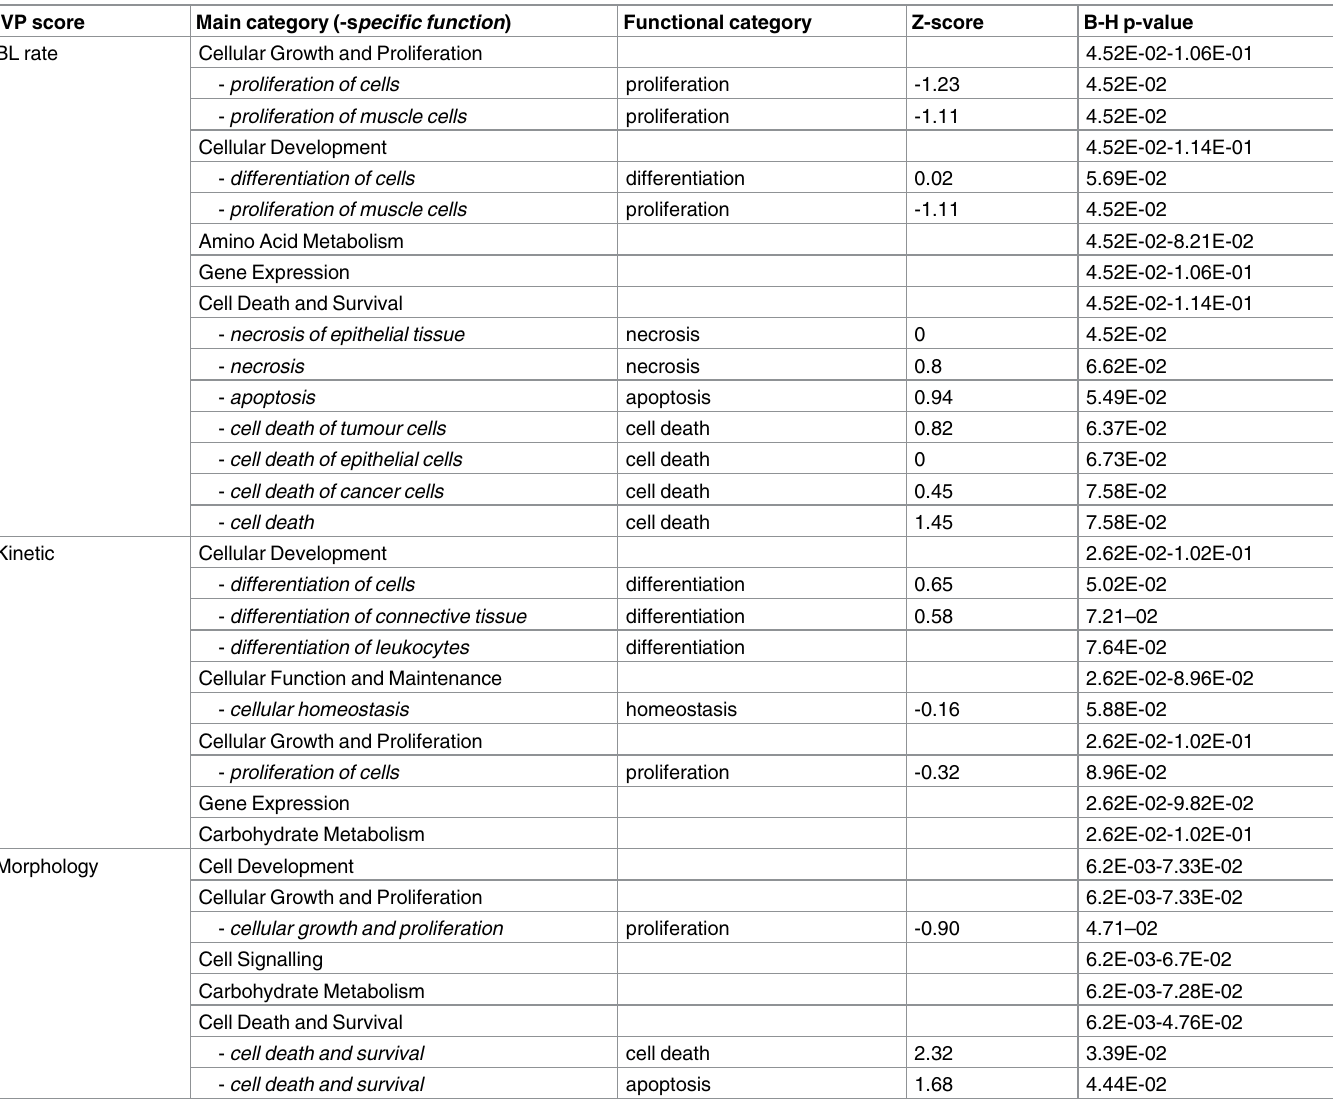
Table 6. Molecular and cellular functions enriched in IPA ® .